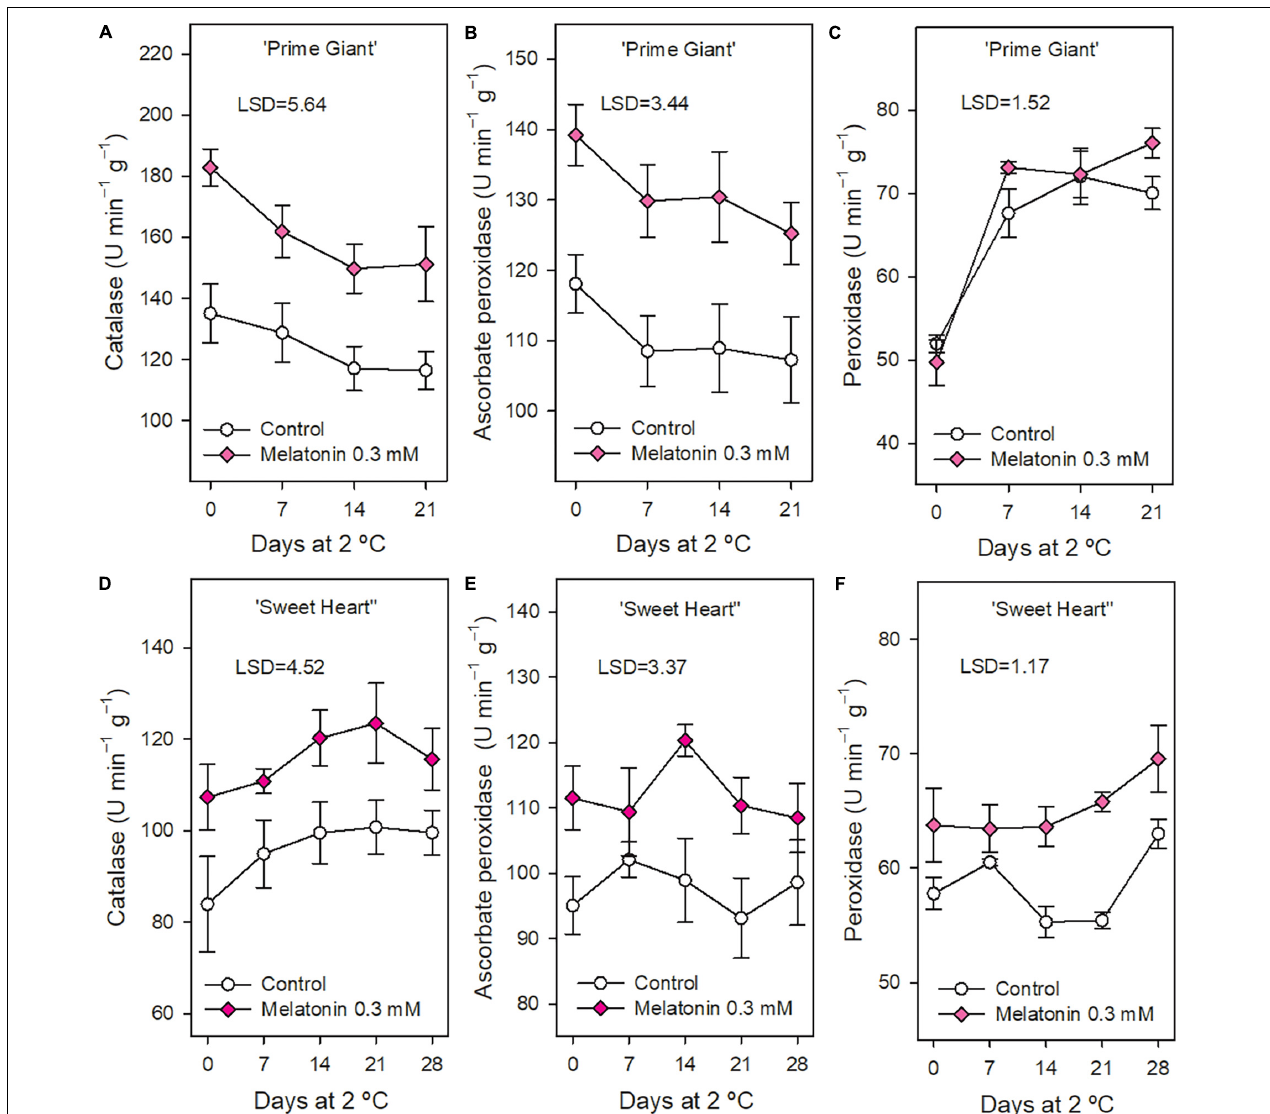
FIGURE 5 | Catalase, ascorbate peroxidase, and peroxidase activities in ‘Prime Giant’ ( A–C , respectively) and ‘Sweet Heart’ ( D–F , respectively) cultivars during storage at 2 ◦ C as affected by melatonin pre-harvest treatments. Data are the mean ± SE of three replicates. LSD values at ( p < 0.05) are shown in each